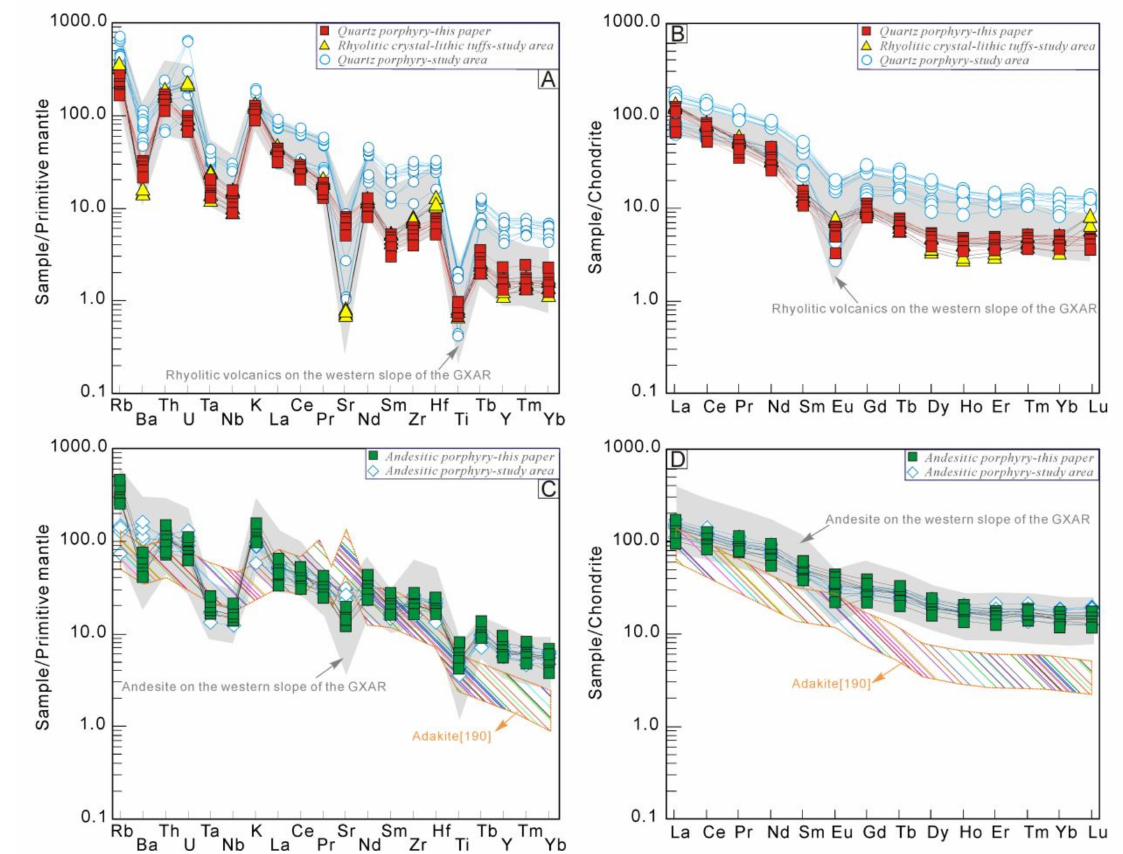
Figure 6. ( A ) Primitive mantle-normalized trace element spider diagrams of the quartz porphyry samples in the Erdaohezi deposit. ( B ) The chondrite-normalized rare earth element (REE) pattern of the quartz porphyry. ( C ) Primitive mantle-normalized trace element spider diagrams of the andesite porphyry samples in the Erdaohezi deposit. ( D ) The chondrite-normalized rare earth element (REE) pattern of the andesite porphyry. Other data are quoted from the literature [22,53,70,71,75].